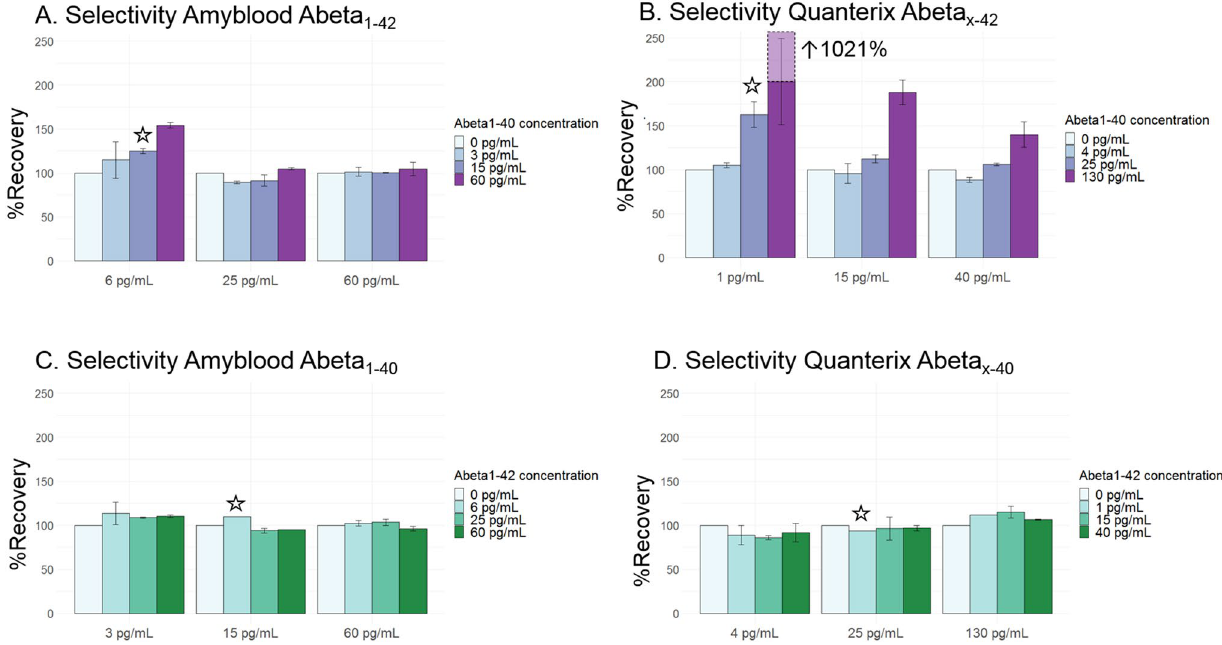
Figure 3. Selectivity of the Amyblood and Quanterix amyloid assays. ( A ) The highest %recovery measured with the Amyblood Abeta 1-42 assay was 125% in the presence of 6 pg/mL Abeta 1-42 and 15 pg/mL Abeta 1-40 . ( B ) The highest %recovery measured with the Quanterix Abeta x-42 assay was 1021% in the presence of 1 pg/mL Abeta 1-42 and 130 pg/mL Abeta 1-40 . ( C ) The highest %recovery measured with the Amyblood Abeta 1-40 assay was 110% in the presence of 3 pg/mL Abeta 1-40 and 6 pg/mL Abeta 1-42 . ( D ) The highest %recovery measured with the Quanterix Abeta x-40 assay was 115% in the presence of 130 pg/mL Abeta 1-40 and 15 pg/mL Abeta 1-40 . The concentrations in buffer nearest to physiological Abeta 1-42 and Abeta 1-40 combinations in plasma as measured with this assay are indicated with an